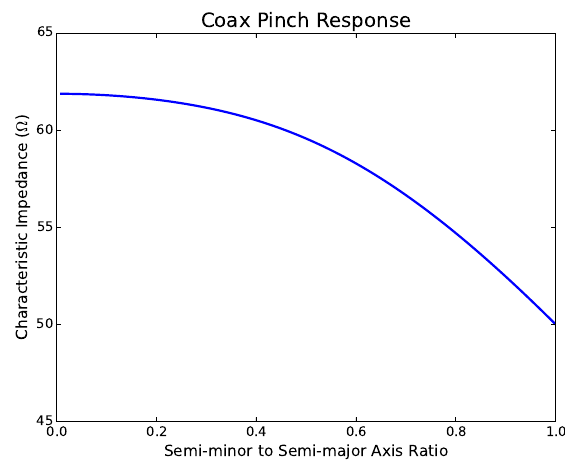
Figure 9. Effect of pinch on the characteristic impedance of the coaxial line.